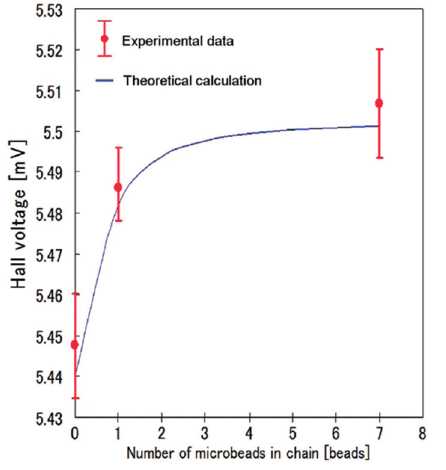
Figure 11. Hall voltage related to chains of self-assembled micro-SPBs bound to sensor. Data points: mean; error bars: standard deviation ( n = 20) Adapted from